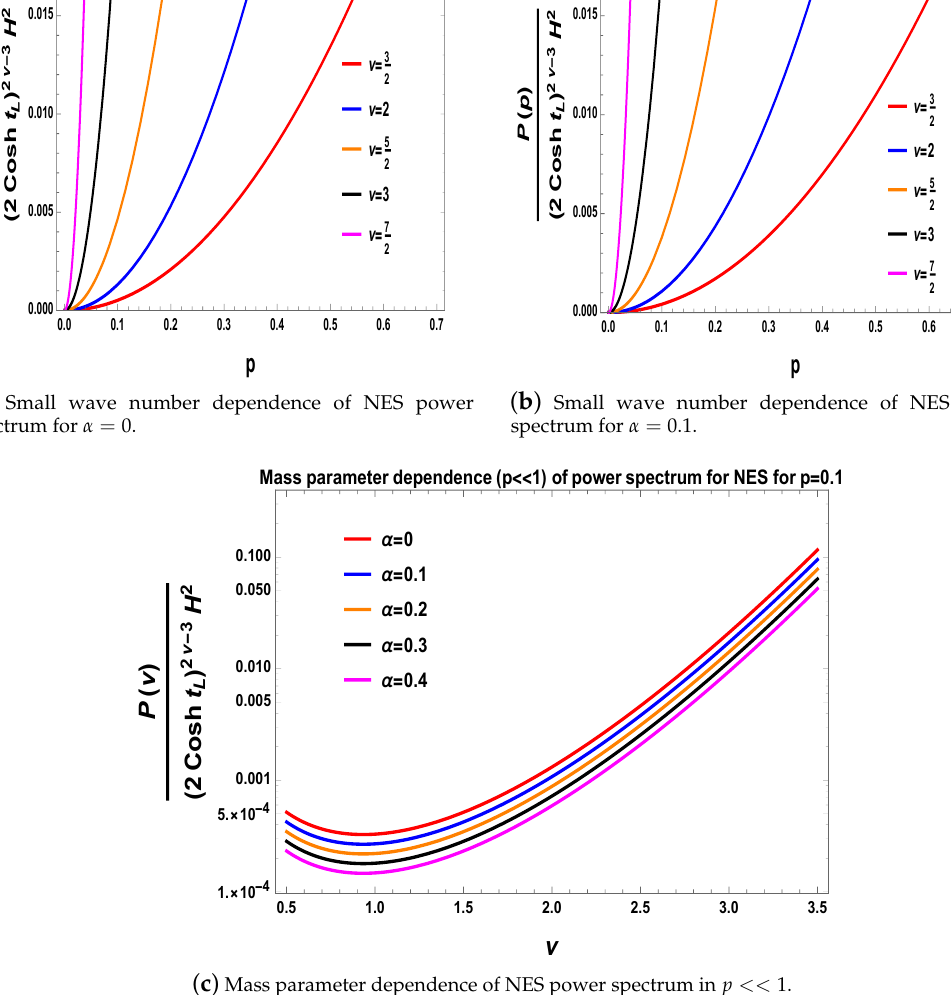
Figure 13. Features of NES power spectrum in small wave number region. ( a ) Small wave number dependence of NES power spectrum for α = 0; ( b ) Small wave number dependence of NES power spectrum for α = 0.1; ( c ) Mass parameter dependence of NES power spectrum in p <<